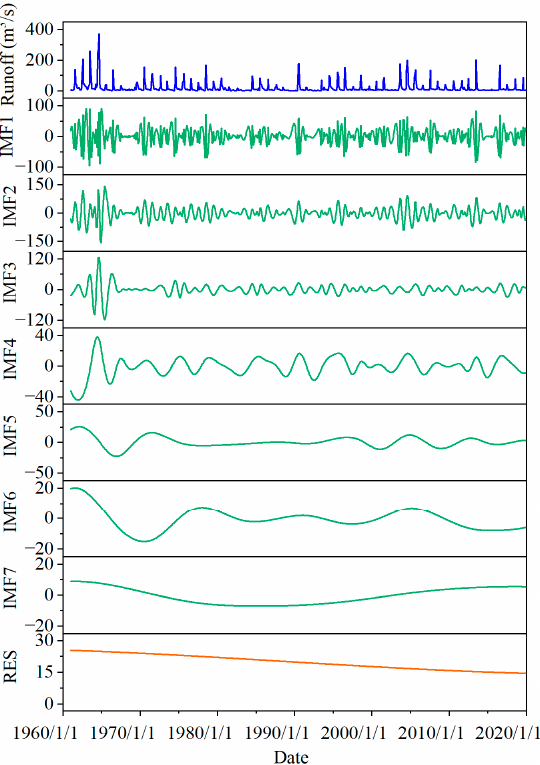
Figure 14. The decomposition results of the CEEMDAN method for runoff at Laiwu station.